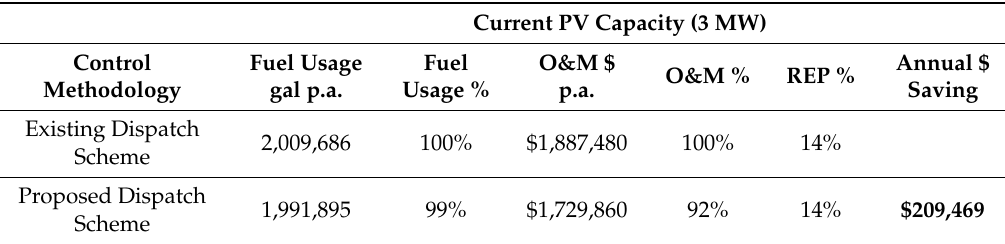
Table 7. Performance of existing and proposed low-load dispatch scheme 3 MW solar PV.